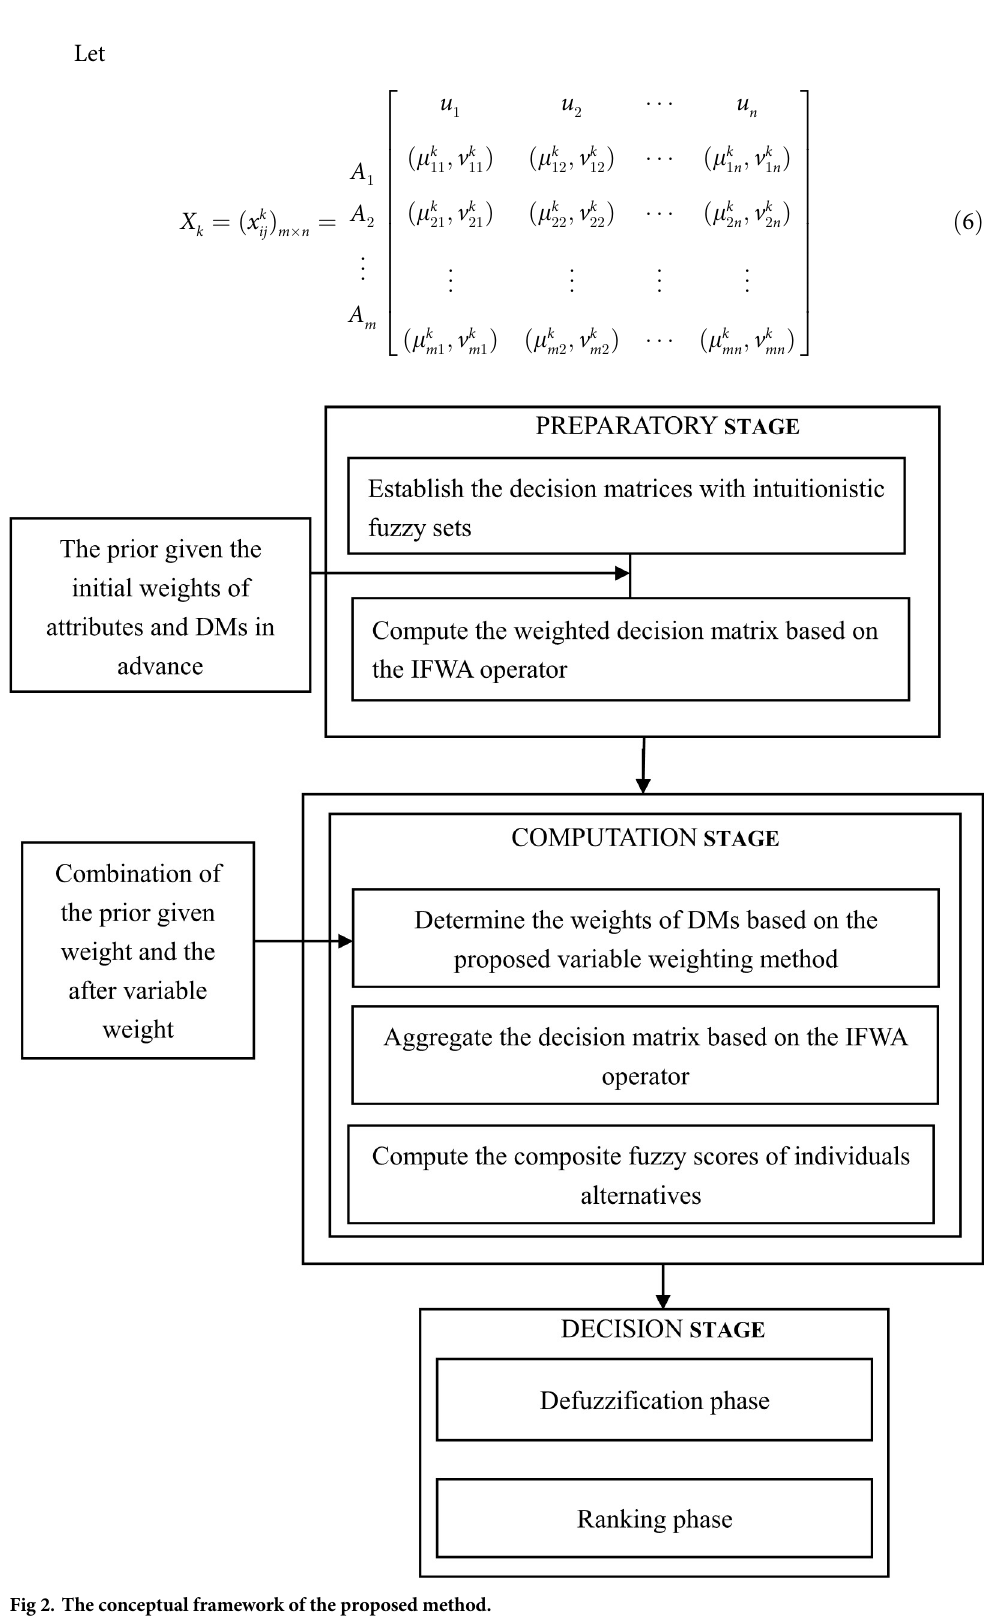
Fig 2. The conceptual framework of the proposed